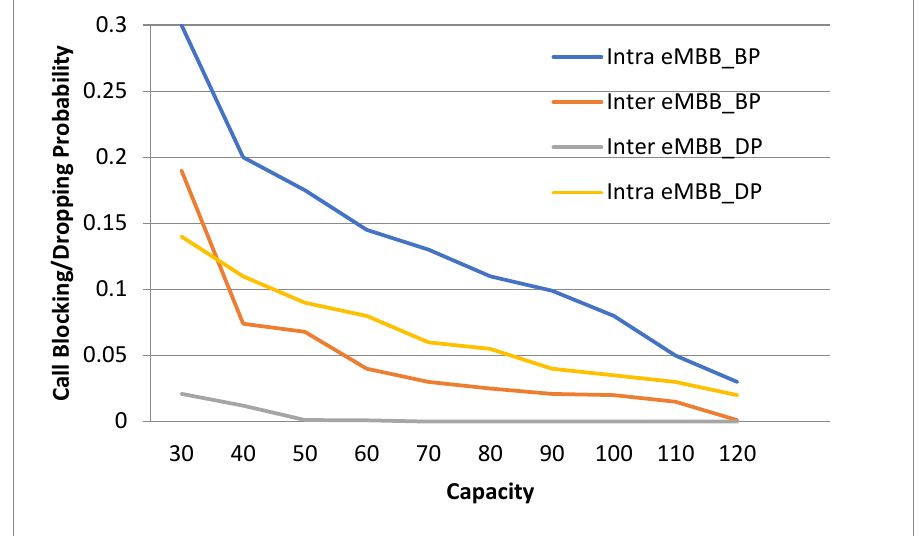
Figure 2. Call Blocking/Dropping Probability of eMBB Intra and Inter Slice .